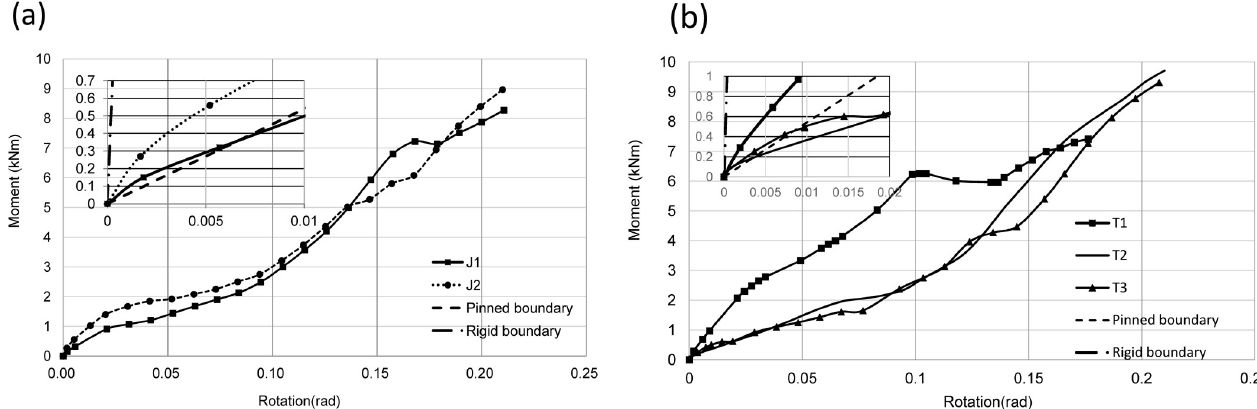
Fig 8. Moment-rotation curves. (a) J group;(b) T group.